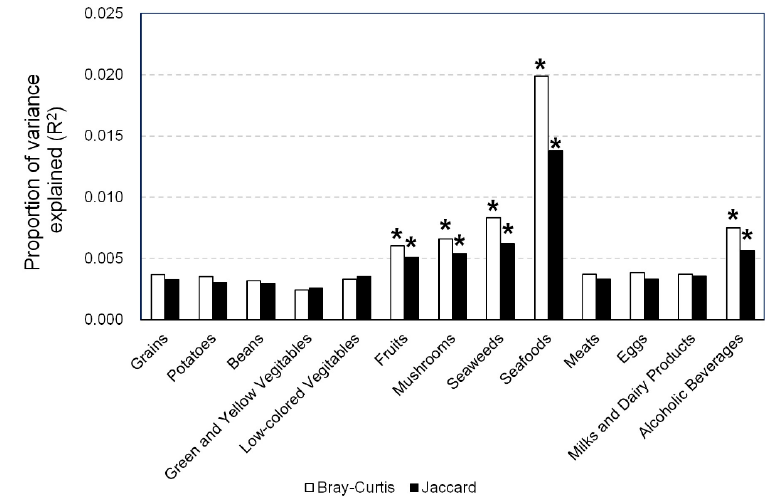
Figure 3. Association between β-diversity of gut microbiota and intake of each food group. The proportion of variance explained ( R 2 ) of each food group was calculated by analyzing the association of β-diversity indexes (Bray–Curtis and Jaccard) and dietary intake using permutational ANOVA (PERMANOVA) adjusted for sex, age, BMI, smoking habit, and total energy intake. * p < 0.05. 3.4. Associations between Number of Gut Bacteria and Food Intake Related to α-Diversity of Gut Microbiota In multiple regression analysis of food groups related to α-diversity of gut microbiota and number of gut bacteria, intake of mushrooms (also related to β-diversity) was associated negatively with the number of Parabacteroides (Table 3). Intake of grains was correlated positively with numbers of Bacteroides , Streptococcus , and Veillonella and negatively with numbers of Lactobacillus and Lactococcus . Intake of beans was correlated positively with numbers of Prevotella , Bacillus , Clostridium , Roseburia , Faecalibacterium , Ruminococcus , and Meganomas and negatively with numbers of Eubacterium and Fusobacterium . Table 3. Significant associations between food groups associated with α-diversity and numbers of gut bacteria at the genus level.